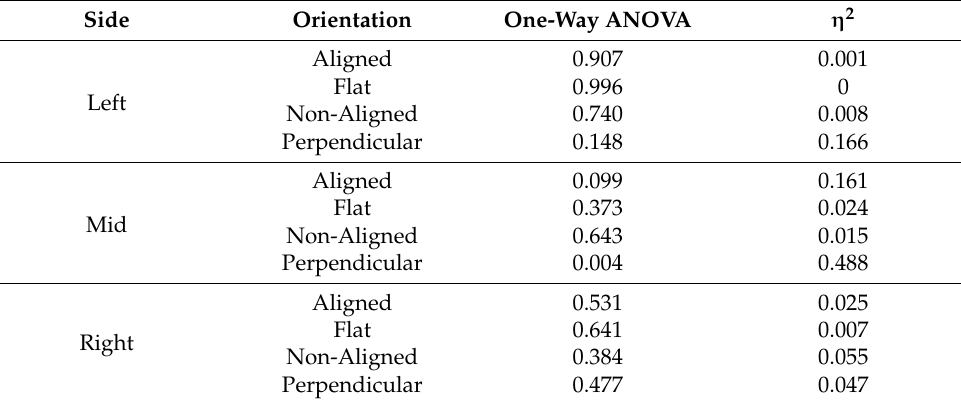
Table 2. Comparison of stimulated and non-stimulated cells growing on different fiber orientations and positions in the EF. Cells growing on aligned fibers perpendicular to and in the middle of the EF demonstrate statistically significant changes in the expression levels of BDNF. These cells have an η 2 of 0.488, suggesting a large effect on the expression of BDNF. Cells lying in the middle on aligned fibers and those lying on the left but perpendicular to the EF, an η 2 of 0.161 and 0.166, respectively, suggesting a large effect of EF on the expression of BDNF. η 2 0.01 = small effect size; 0.06 = medium; 0.14 and higher = large effect